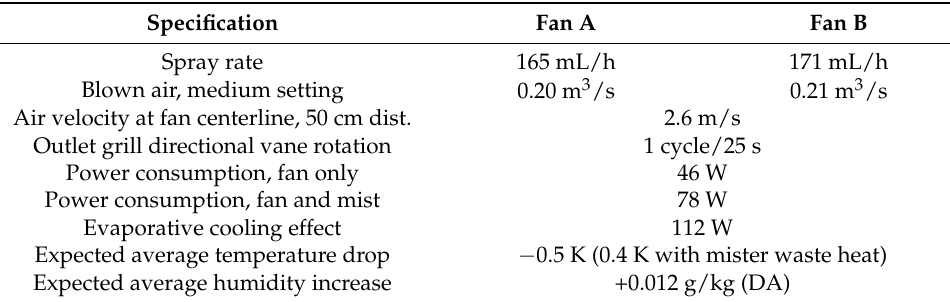
Table 2. Characteristics of the misting